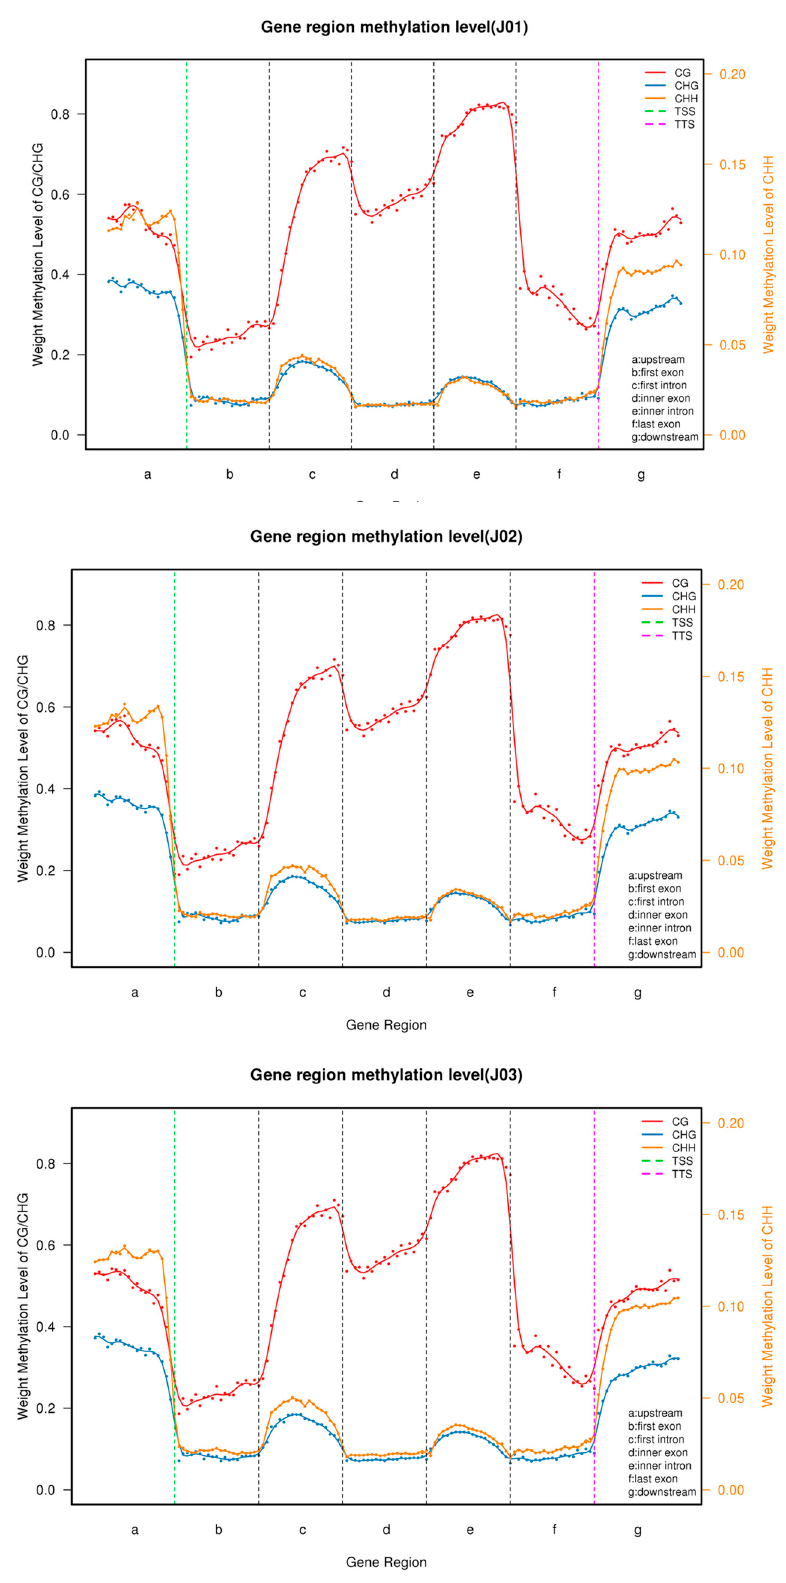
Figure 3. The DNA methylation levels of different gene regions of different samples. The methylation levels of the different gene regions from the different samples showed the same trends. The CG type was found more frequently than the CHG and CHH types, which showed almost the same level of occurrence. J01 represents the CK, J02 represents the sense, and J03 represents the antisense samples. TSS: Transcriptional Start Site; TTS: Transcriptional Termination Site.